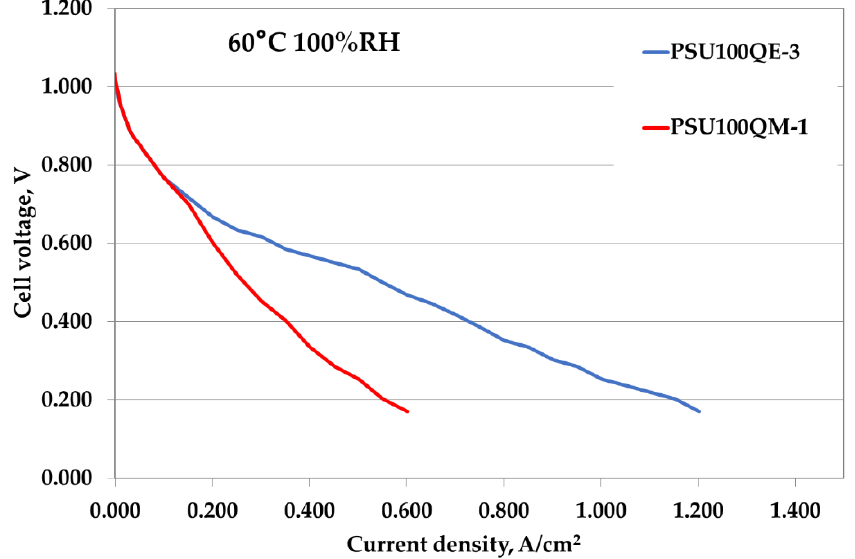
Figure 7. Polarization curves comparison of PSU-based membrane electrodes assemblies (MEAs).